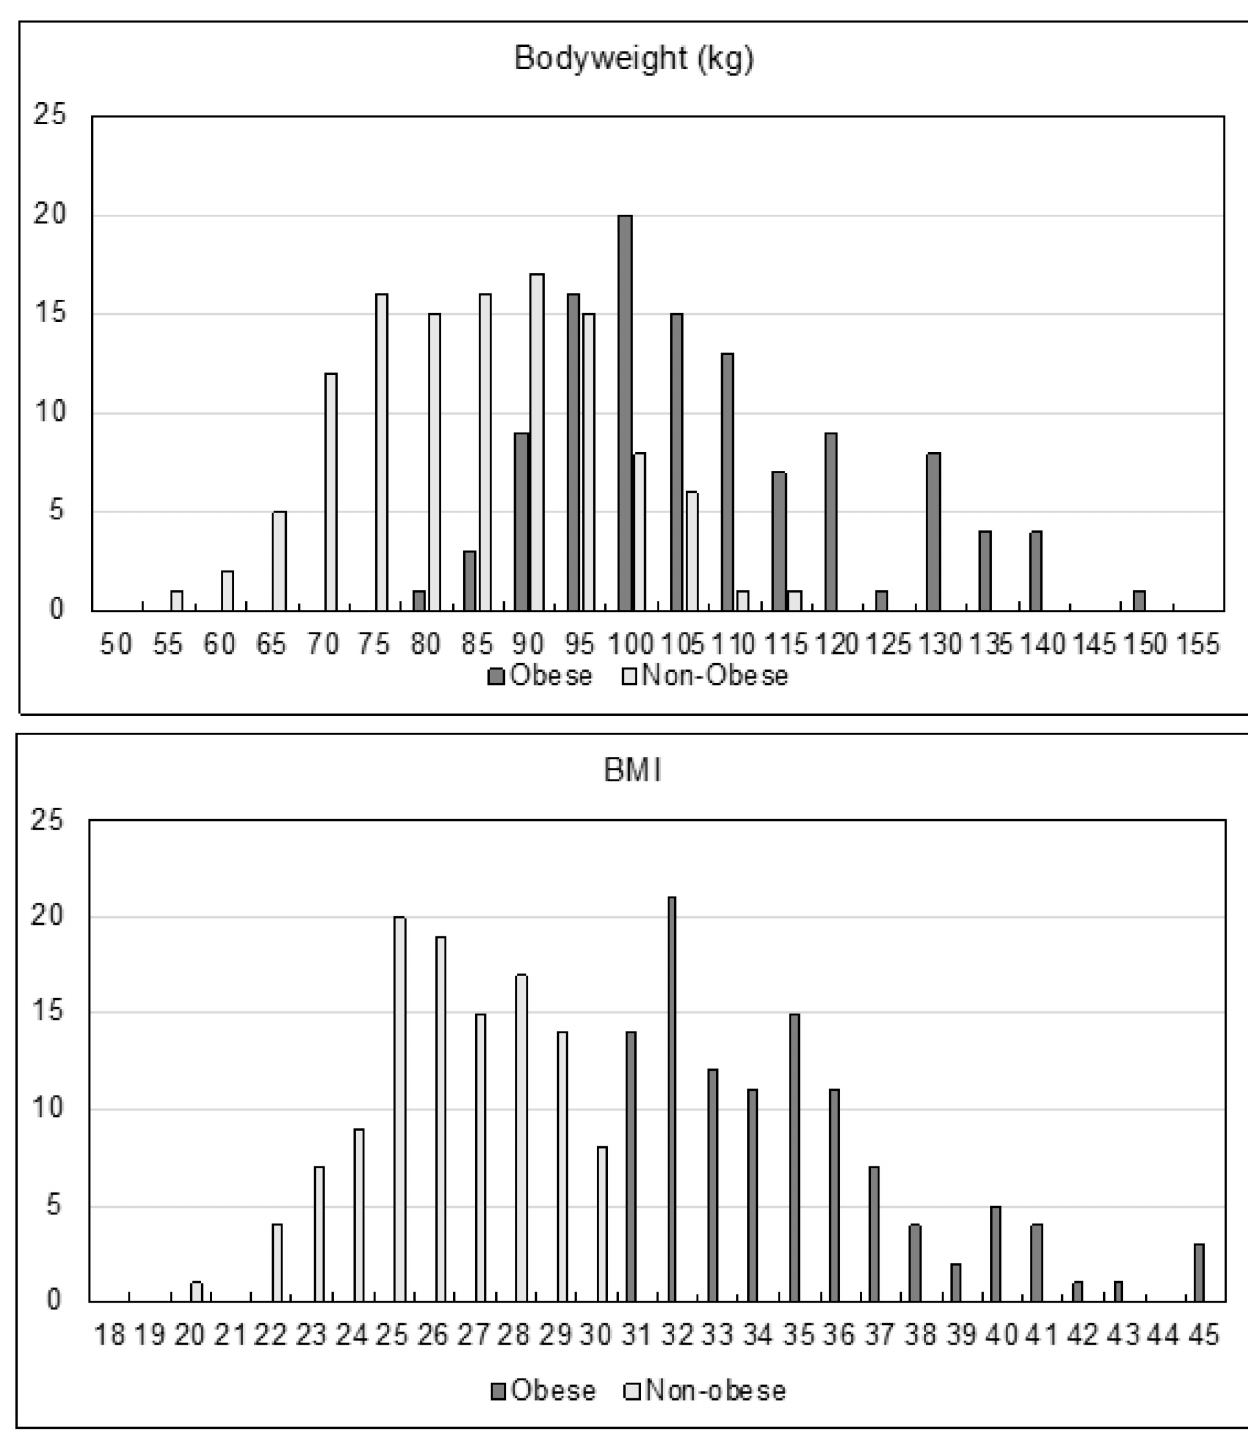
Figure 1. Histogram of patient’s body weight and BMI at